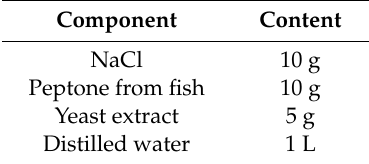
Table 2. The composition of Luria-Bertani (LB)